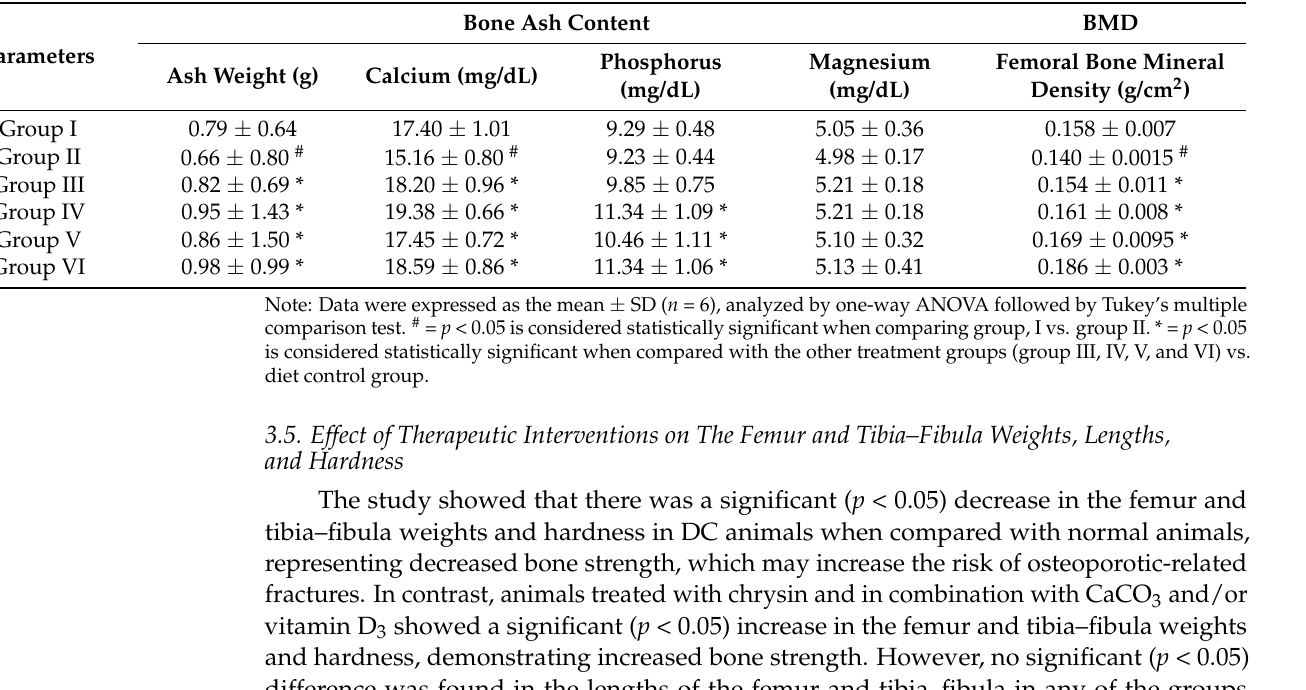
Table 3. Effect of drug treatment groups on bone ash content (ash weight, calcium, phosphorus, and magnesium levels) and femur bone mineral density